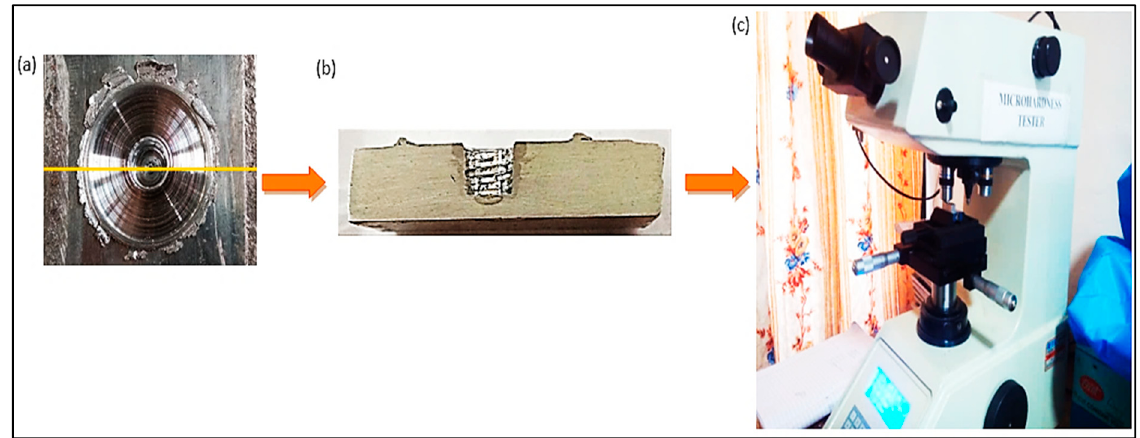
Figure 8. ( a ) FSSW weld; ( b ) FSSW weld cut in half; ( c ) micro-hardness tester.